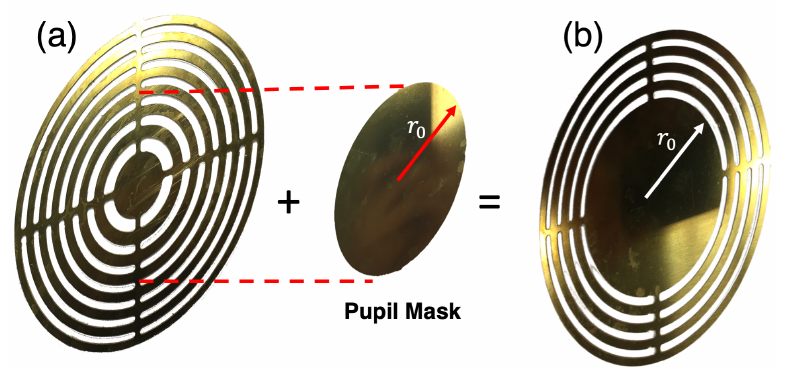
Figure 4. Implemented lenses in brass for the experimental results; where ( a ) corresponds to the experimental classical Soret Zone Plate (SZP) and ( b ) corresponds to the implemented Pupil masked Soret Zone Plate (PSZP).